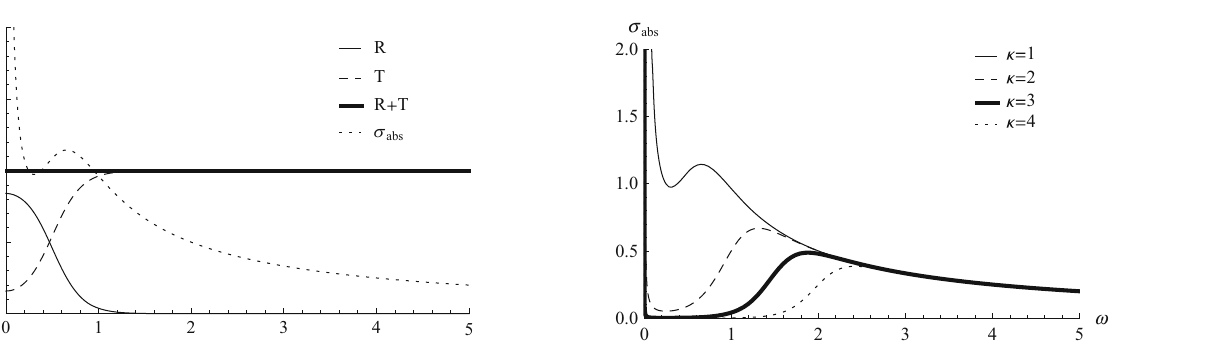
Fig. 3 The absorption cross section σ abs as a function of ω ; for κ = 1 , 2 , 3 , 4 and r + =